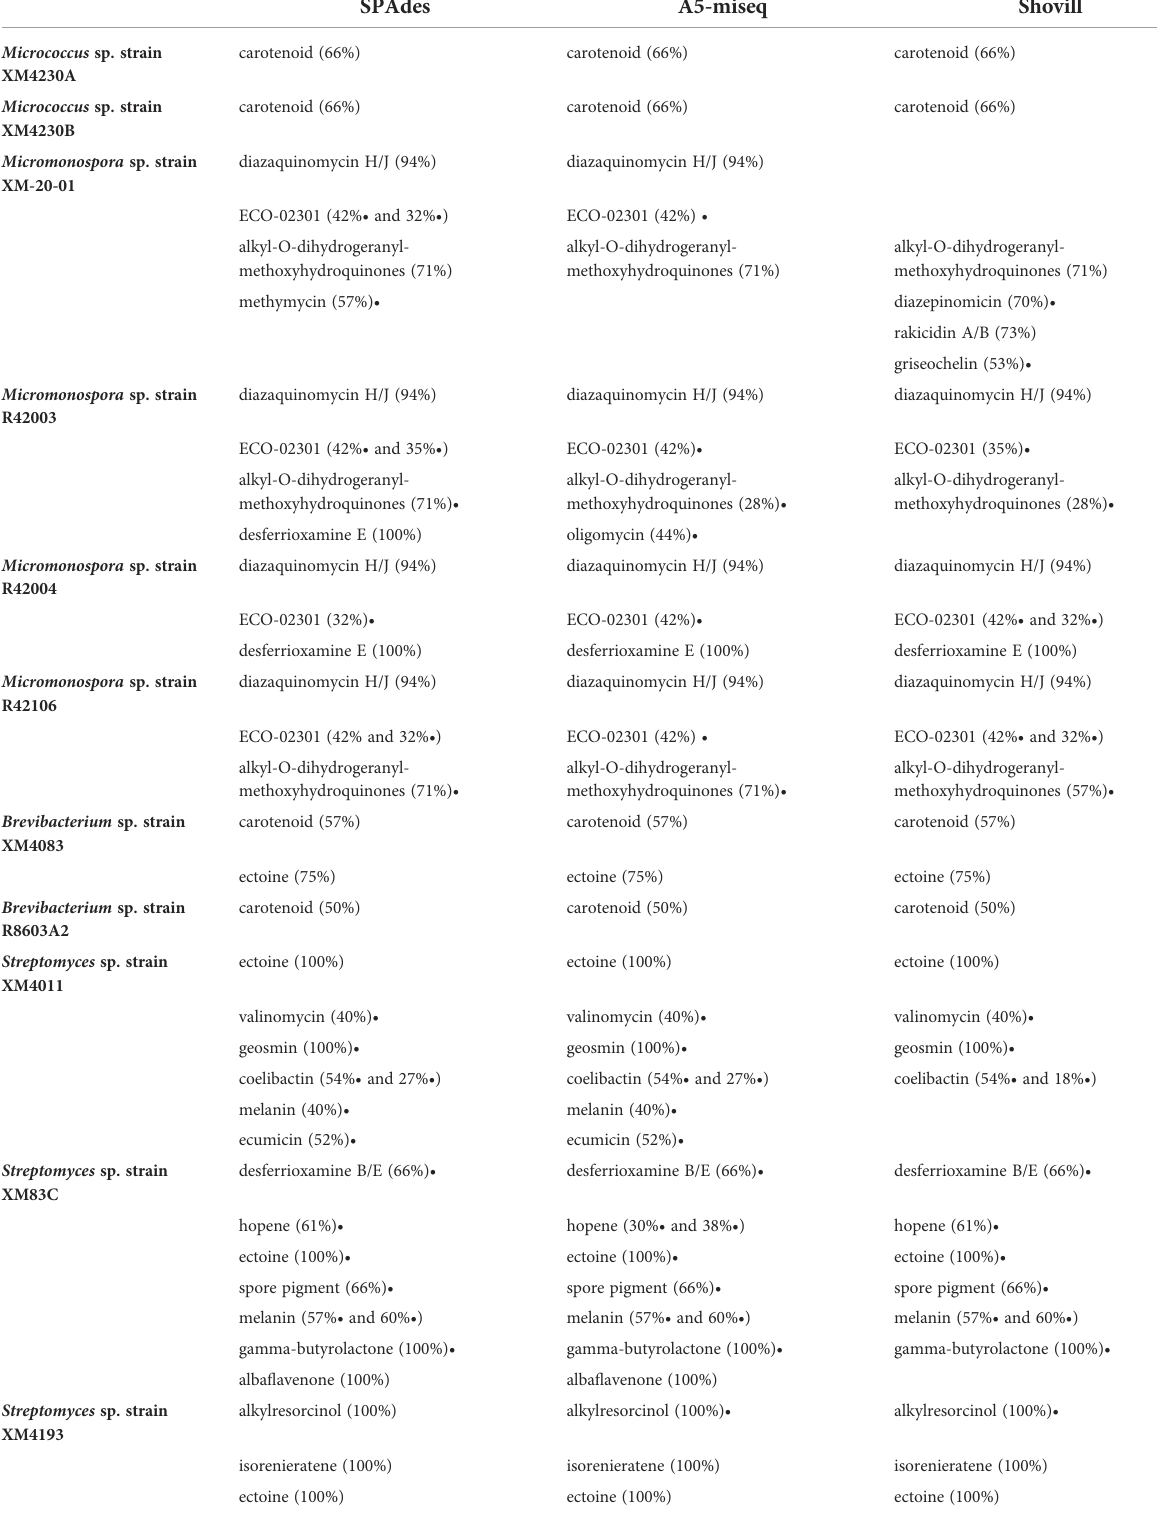
TABLE 6 Putative BGCs identi fi ed by antiSMASH for actinomycete strains based on assembly method